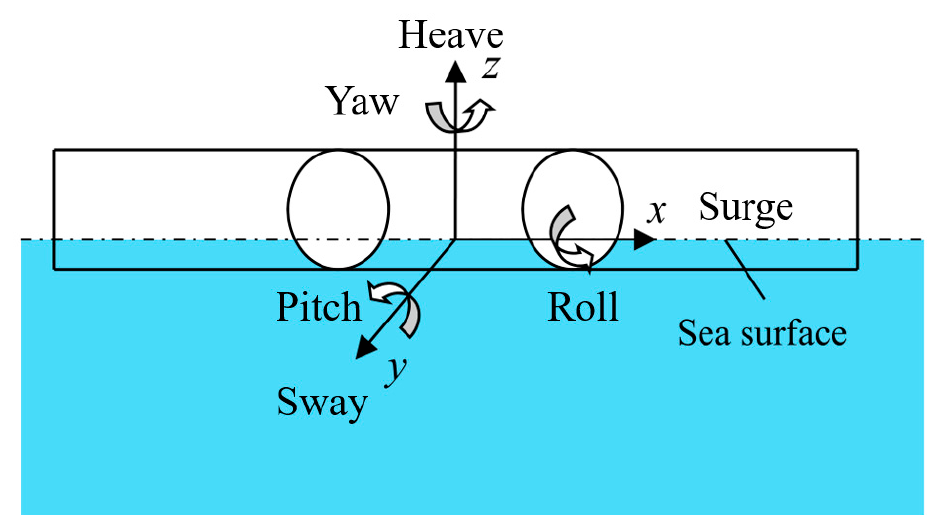
Figure 3. The coordinate system setting of the floating platform.